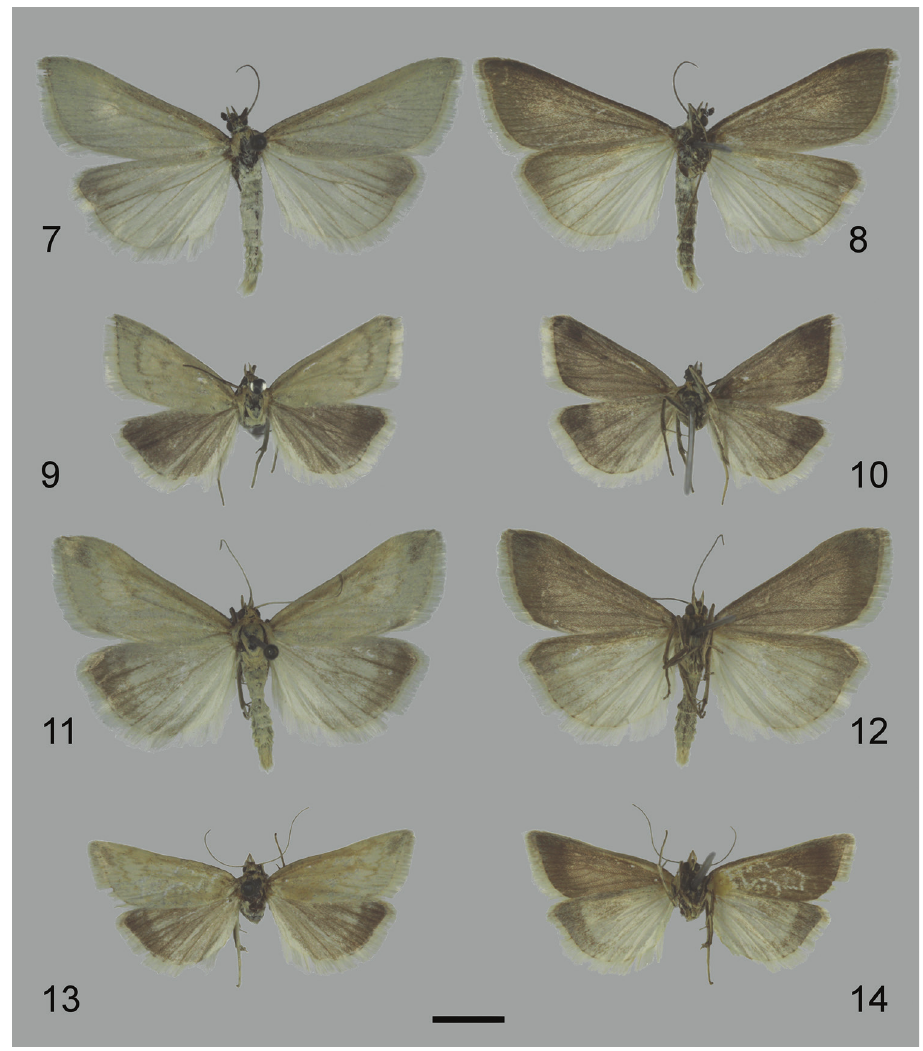
Figures 7–14. Adult specimens of Udea species. 7–10 U. austriacalis 7–8 male, dorsal ( 7 ) and ventral ( 8 ) 9–10 female, dorsal ( 9 ) and ventral ( 10 ), abdomen removed 11–14 U. donzelalis 11–12 male, dorsal ( 11 ) and ventral ( 12 ) 13–14 female, dorsal ( 13 ) and ventral ( 14 ), abdomen removed. Scale bars: 500 µm.